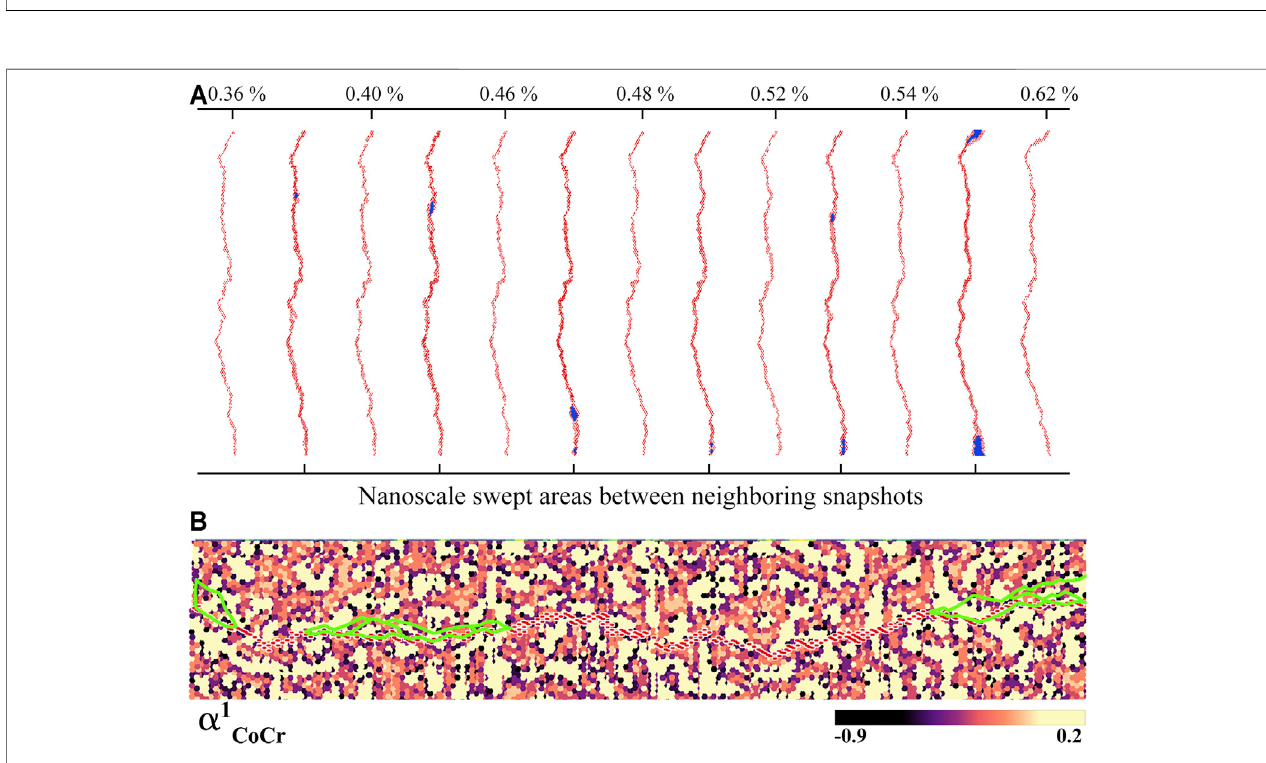
FIGURE 5 | Dislocation motion via nanoscale segment detrapping mechanism for the sample annealed at 450 K (without nanoprecipitates). (A) Snapshots at varying shear strains showing nanoscale segment detrapping process, in which the swept areas between two neighboring snapshots are highlighted in blue color. (B) Correlation between nanoscale segment detrapping events and spatial deviations from local chemical ordering. (Atoms are colored according to the value of α 1 Co − Cr .)